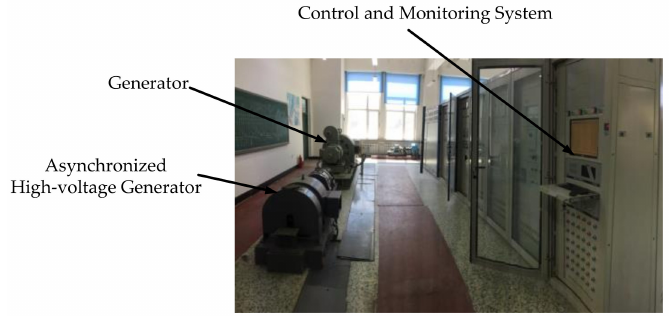
Figure 4. Power system dynamic simulation